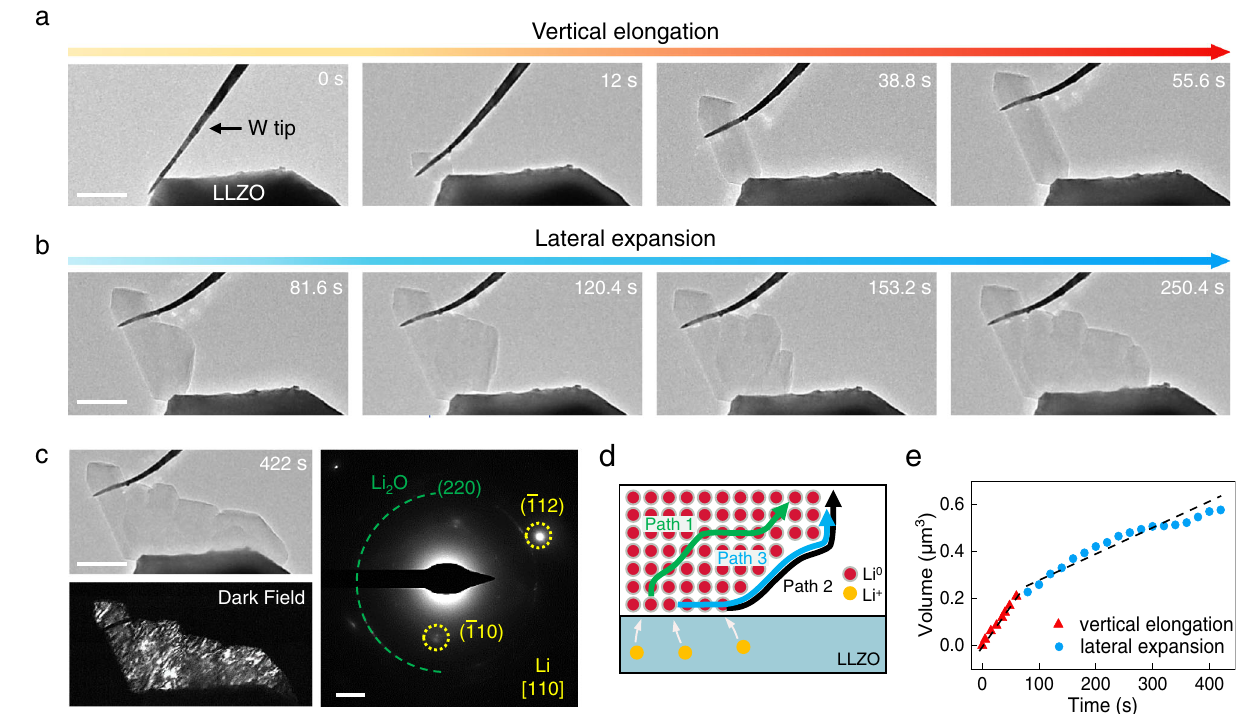
Fig. 2 | Vertical growth and lateral extension of Li metal under an increasing stack pressure imposed by a slender W current collector. a Vertical elongation of a Li whisker by root growth leading to increase in stack pressure from the bending W tip. b Lateral swelling (81.6s) of the Li whisker under a strong com- pressivestressandthefollowinglateralexpansionofLi,whichenlargestheLi|LLZO interface. c Bright fi eld and dark- fi eld (DF) images of the deposited Li at the fi